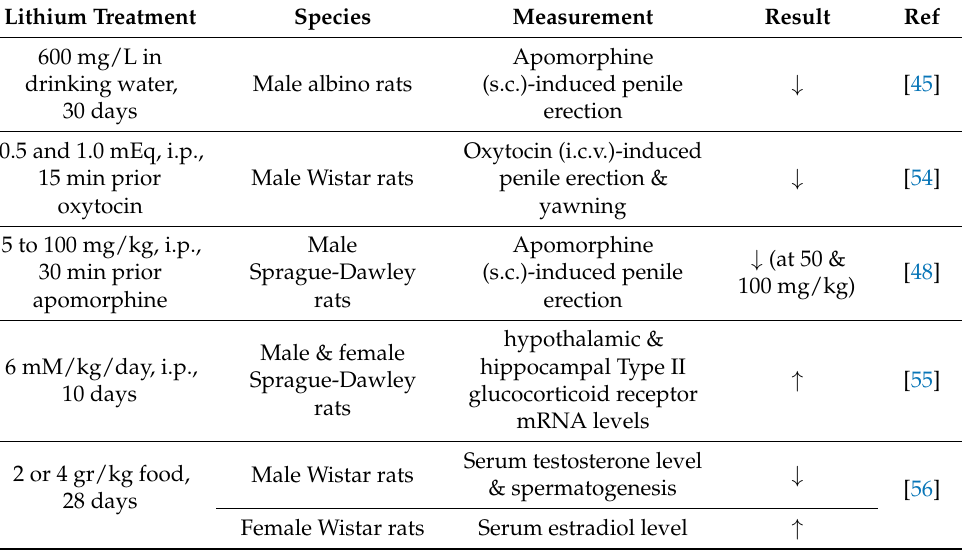
Table 1. Effects of lithium on erectile function in preclinical